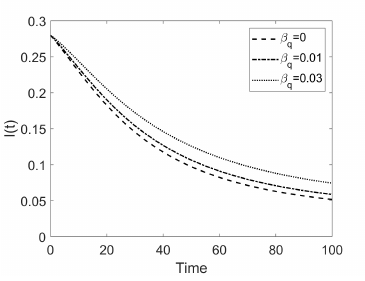
Figure 6. Evolution of I ( t ) for different values of β q where (cid:15) = 0 . 02 ,α = 0 . 02 ,γ = 0 . 03 ,β w = 0 . 1 ,β s = 0 . 04 ,δ = 0 . 027 ,η = 0 . 02 ,µ = 0 .